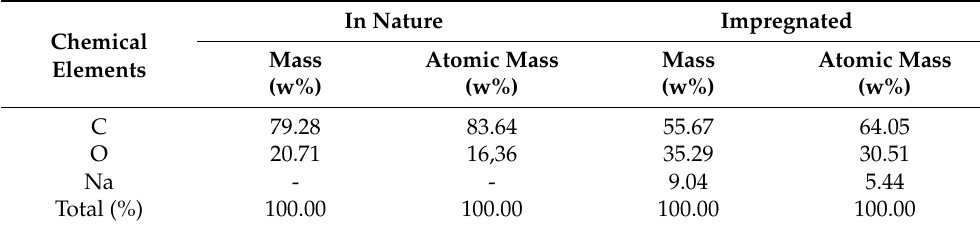
Table 2. EDX analysis of aça í seeds in nature and